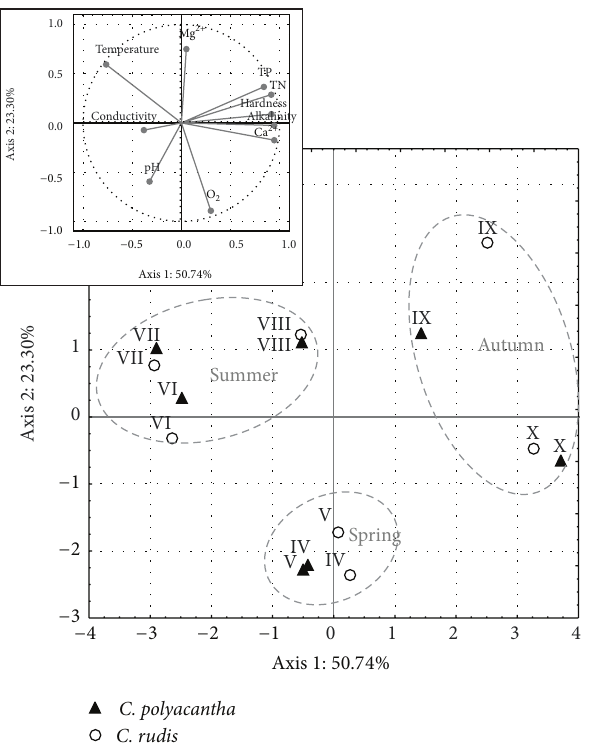
Figure 3: The Principal Components Analysis (PCA) of water properties data gathered during the month-to-month study of C. polyacantha and C. rudis in Lake Jasne in the 2010 vegetation season. Total phosphorus (TP) and total nitrogen (TN) concentrations represent all the analysed speciation forms of both nutrients. The empty symbols represent C. rudis and the filled ones represent C. polyacantha .Theromannumbersmeanthemonthsofstudy.Dashed grey lines mark the